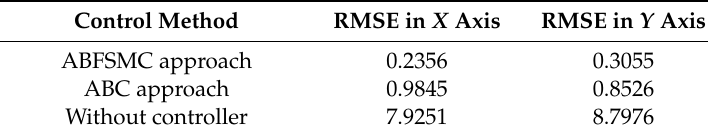
Table 2. Root mean square errors (RMSE) of tracking error in x-axis and y-axis using three controllers.